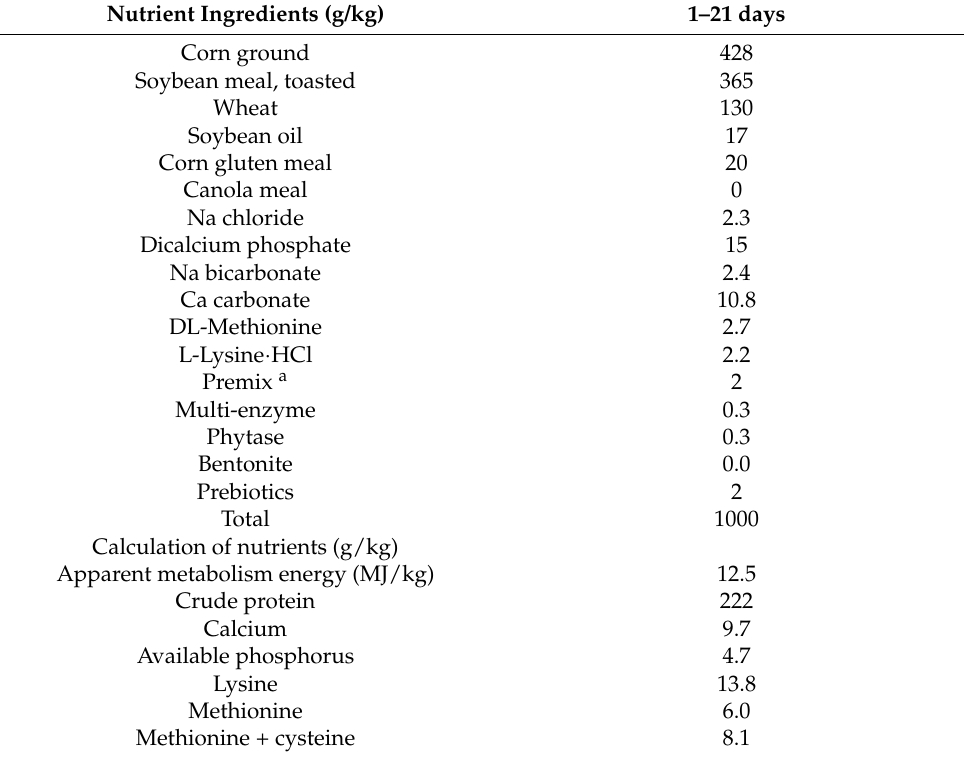
Table 1. Composition of basal diets used in the trial for broilers 1–21 days of age. Nutrient Ingredients